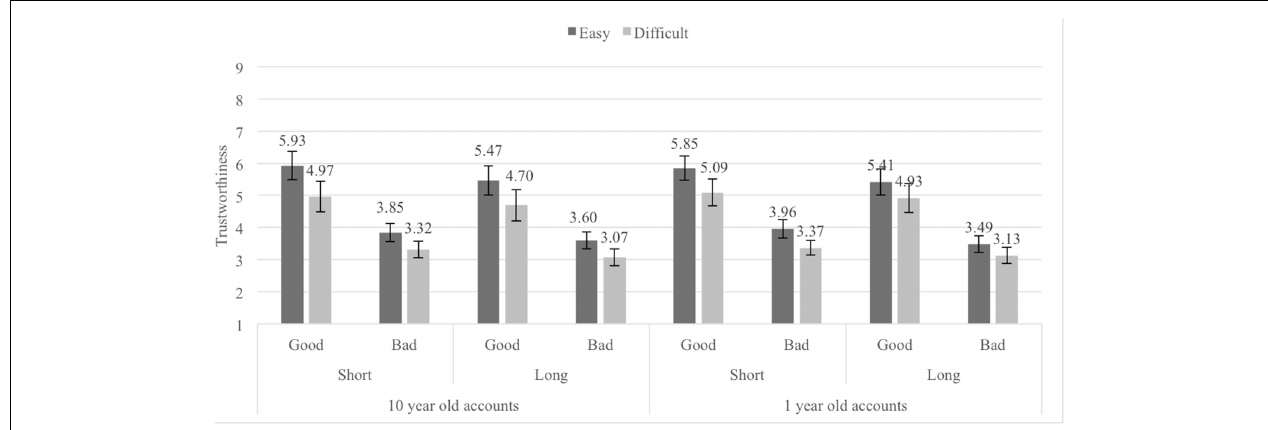
FIGURE 9 | Average trustworthiness ratings in Experiment 7, by Age of the eBay accounts, Length, Pronounceability and Reputation conditions; error bars denote standard errors.